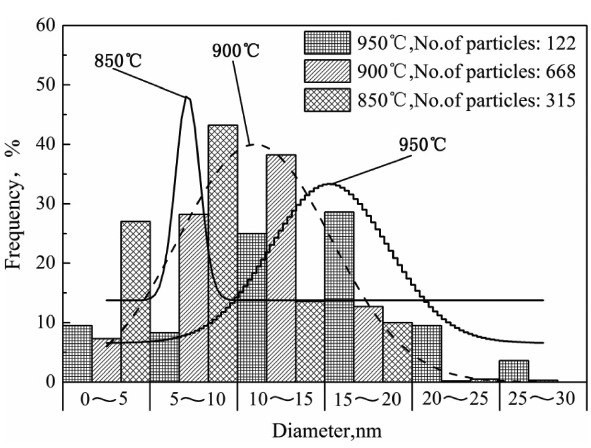
Fig. 10: Size distribution of precipitates as a function of temperature in Ti-bearing steel.